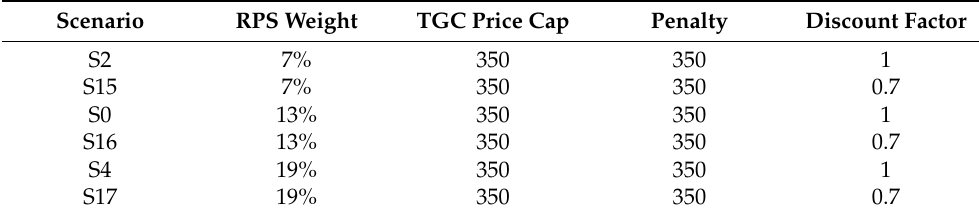
Table 5. Scenarios for analyzing impacts of discount factors under different RPS